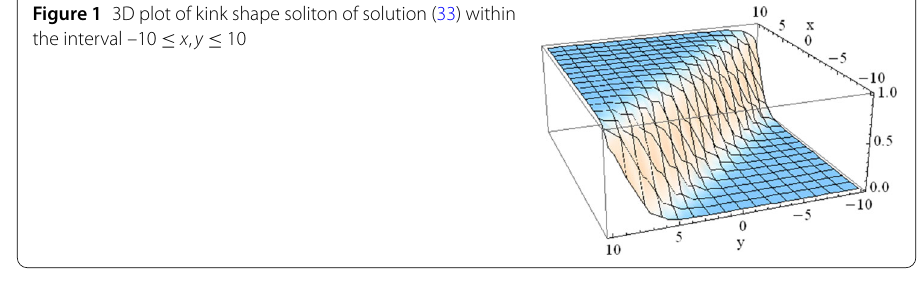
Figure 2 3D plot of singular kink shape soliton of solution (24) within the interval –10 ≤ x , y ≤ 10